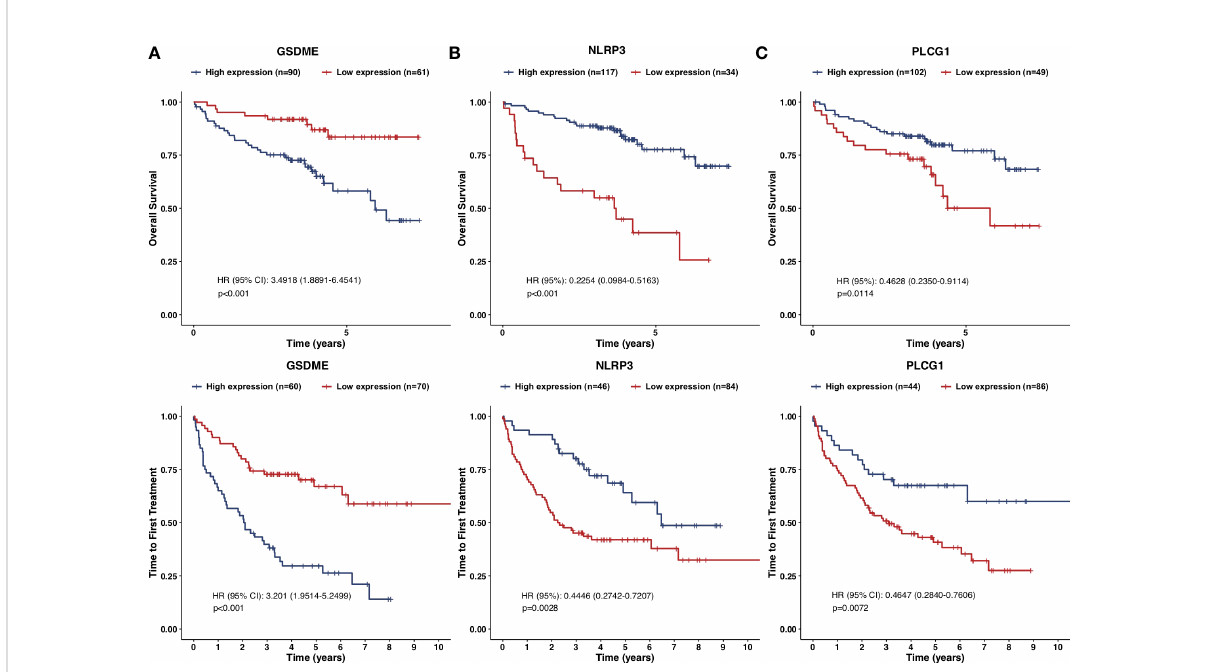
FIGURE 5 Kaplan – Meier plots of the prognostic pyroptosis-related genes. (A – C) Kaplan – Meier plots showed the screened pyroptosis-related genes in prognostic models with OS and TTFT: (A) GSDME; (B) NLRP3; (C) PLCG1.